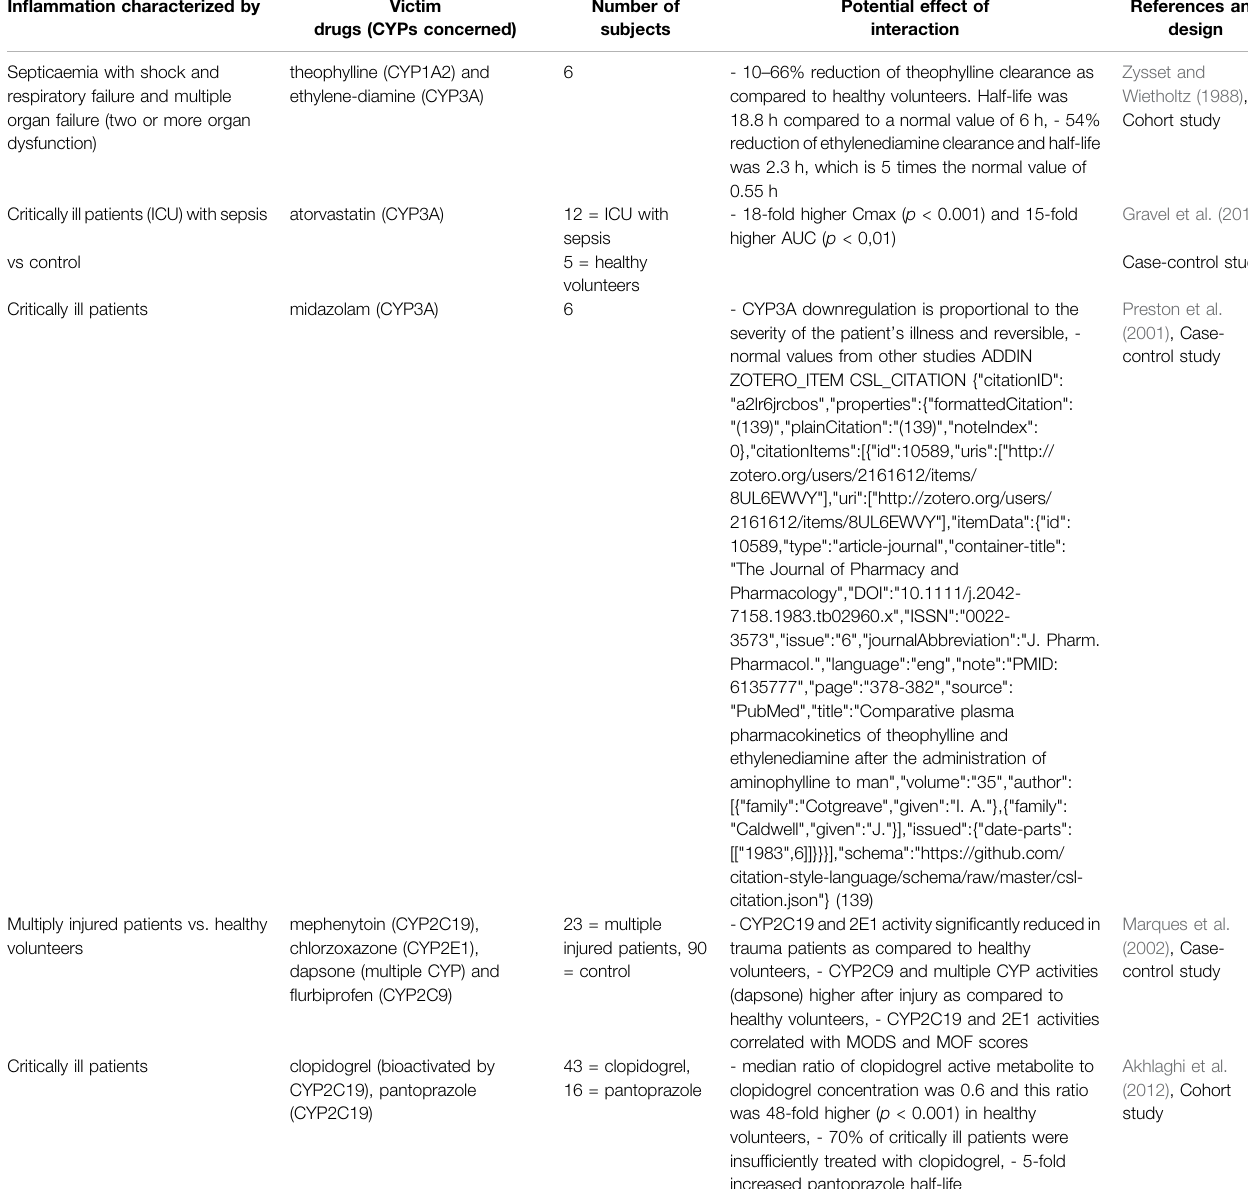
TABLE 8 | Impact of critically ill patients on CYP substrates, explained totally or partially by modulation of CYP activity. In fl ammation characterized